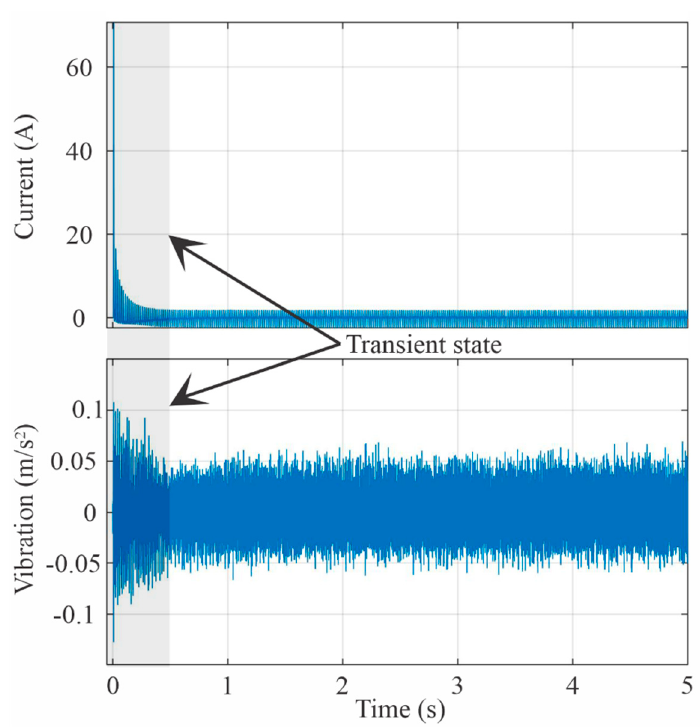
Figure 4. Current and vibration signals.